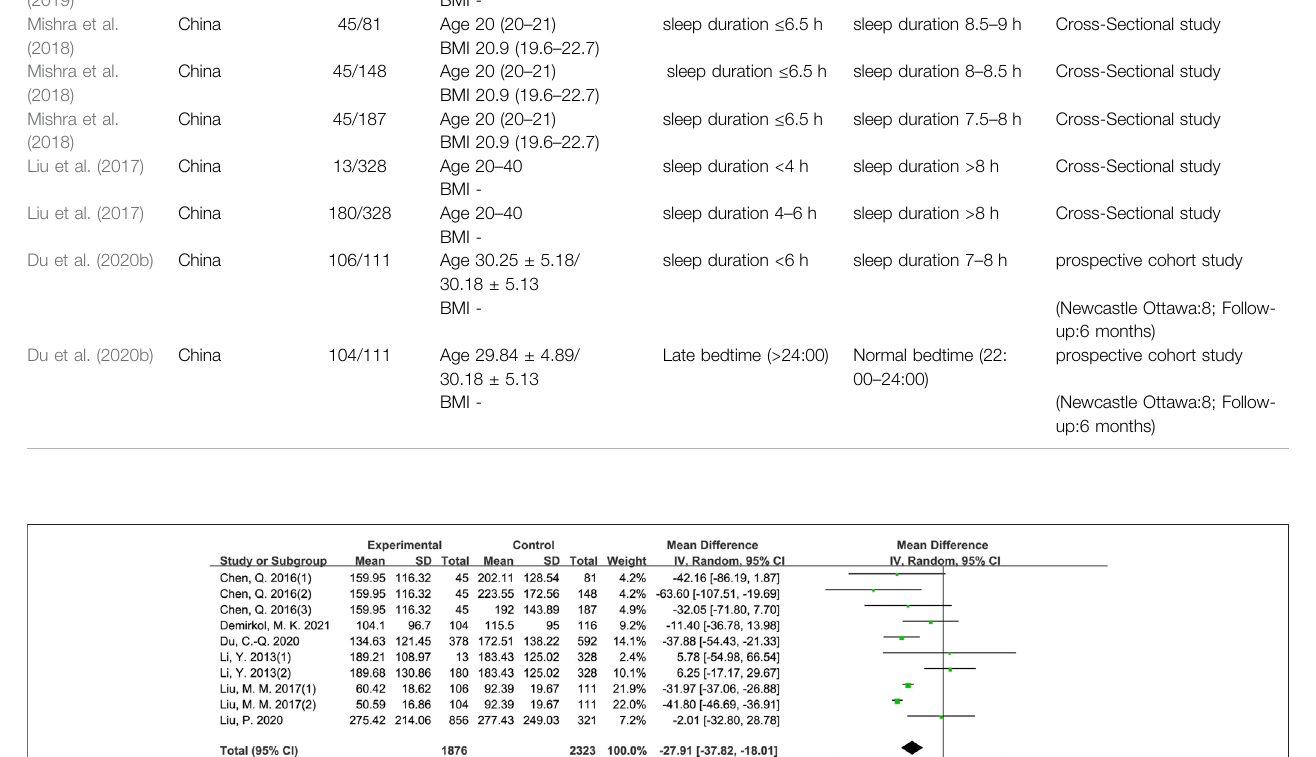
Figure 7A ), FSH (MD = 0.44, 95% CI = ( − 0.76, 1.64), p = 0.47; Figure 7B ) and LH (MD = 0.03, 95% CI = ( − 0.66, 0.72), p = 0.93; Figure 7C ) when compared to the control group. No signi fi cant publication bias was found in the results of Begg ’ s plots and Egger ’ s test for total sperm count ( p = 1.8926/